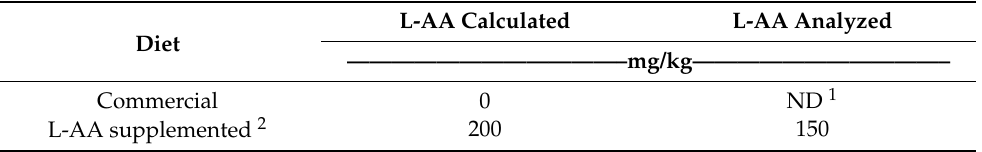
Table 2. The calculated and analyzed values of L-ascorbic acid (L-AA) concentrations of standard commercial and L-AA-supplemented commercial diets fed in the starter dietary phase. L-AA Calculated L-AA Analyzed Diet Commercial 0 ND 1 L-AA supplemented 2 200